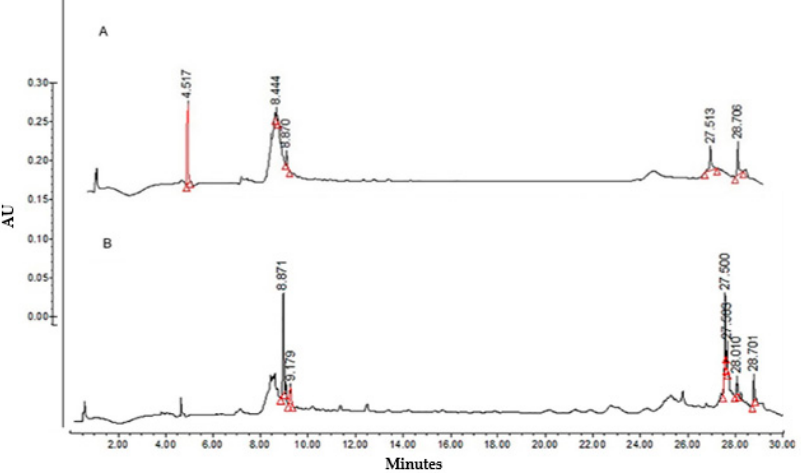
Figure 2. HPLC chromatograms of ( A ) L. tridentata aqueous fraction and ( B ) L. tridentata organic fraction (280 nm).